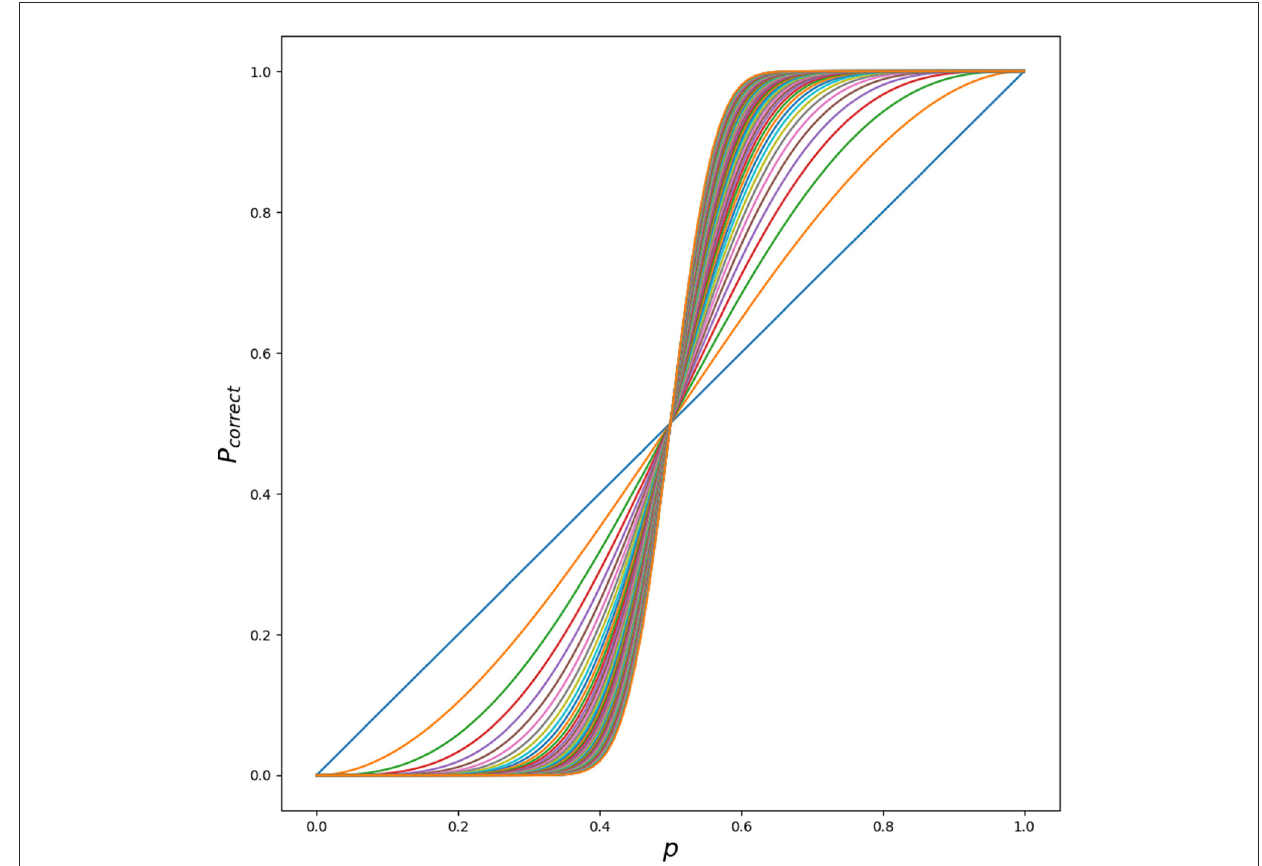
FIGURE4 Different outcomes for P correct for different p ∈ [0.0,1] with increasing k ∈ [0, ... ,51]. Python script is in Appendix